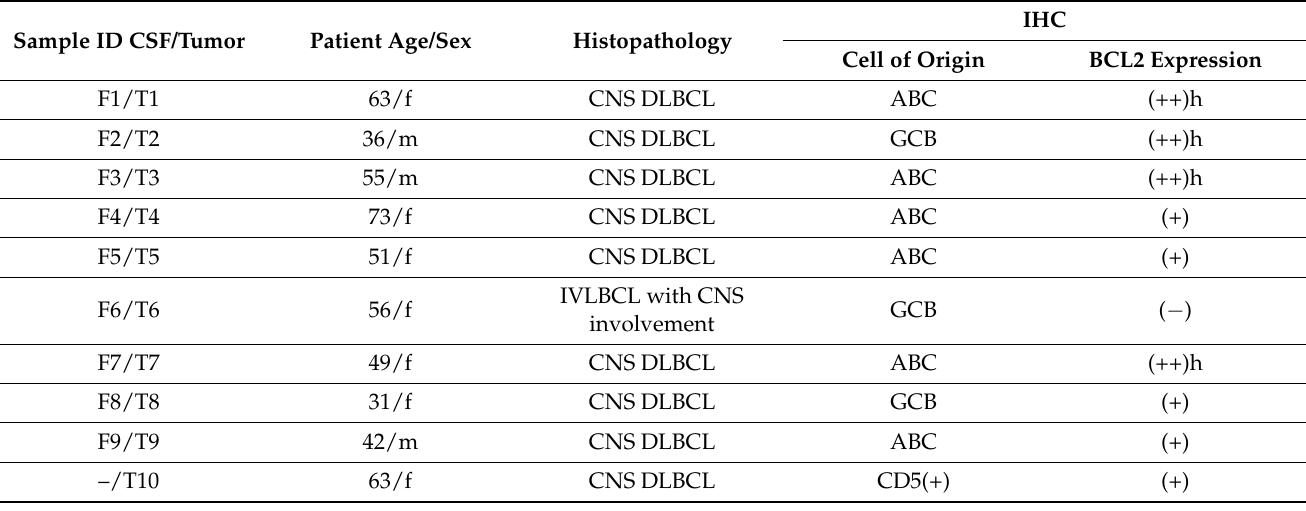
Table 1. Pathomorphological characteristics of the CNS DLBCL samples. Cerebrospinal fluids (F), n = 9; brain tumor samples (T), n = 10.